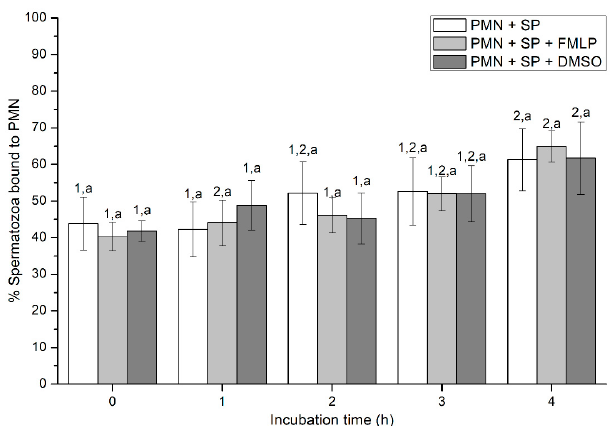
Figure 2. Percentages of spermatozoa bound to PMN in the three treatments (PMN + SP, PMN + SP + FMLP and PMN + SP + DMSO) throughout the incubation time (4 h; Experiment 2). Different superscripts ( a, b ) mean significant ( p < 0.05) differences between treatments within a given time point, and different numbers ( 1, 2 ) mean significant ( p < 0.05) differences between incubation times within a given treatment. Data are shown as mean ± SEM for seven experiments. Sperm concentration: 500 × 10 6 sperm/mL. PMN concentration: 100 × 10 6 PMN/mL. PMN: polymorphonuclear neutrophils; SP: seminal plasma; DMSO: dimethyl sulfoxide; FMLP: formyl-methionyl-leucyl-phenylalanine.